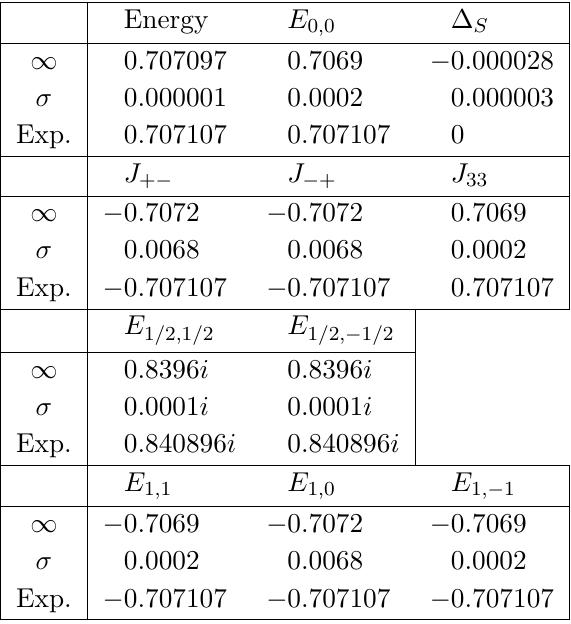
Table 3 . Comparison of extrapolations of observables to their expected values for a solution describing J = 0 boundary state with θ = π in the k = 2 model with J = 1 boundary conditions. 2 2 For each observable, the first line shows the infinite level extrapolation, the second line the estimated error of the extrapolation and the final line the expected value based on θ = π . The extrapolations 2 are based on the level 14 solution which we found in the WZW model, but an improvement is possible using the dual Ising model solution, see table 8.4 in